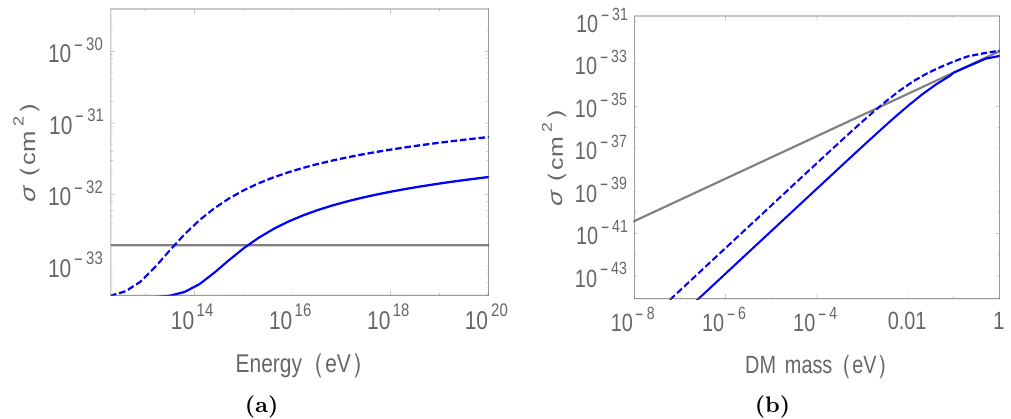
Figure 3. (a) Cross-section vs. incoming neutrino energy. (b) Cross-section vs. mass of DM. Grey line represents the required cross-section to induce 1% suppression of incoming (cid:13)ux. The dashed and solid blue lines represent cross-sections for m Z 0 = 5 ; 10 MeV respectively, (a) with m DM = 0 : 5 eV and (b) with E (cid:23) = 1 PeV. In both plots, c (9) = (cid:3) = 3 : 8 (cid:2) 10 (cid:0) 3 GeV (cid:0) 1 and C 1 = 1. l E(cid:11)ective interactions with thermal